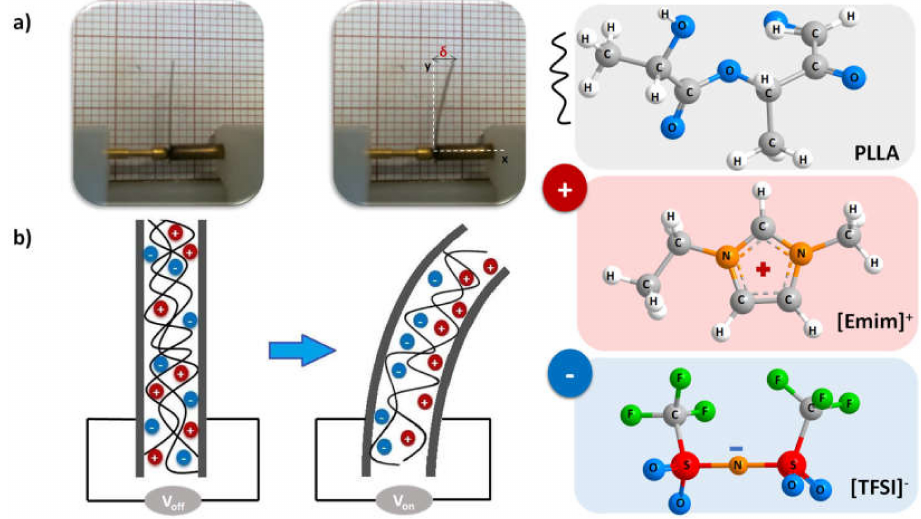
Figure 10. ( a ) Displacement observed for the PLLA / [Emim][TFSI]-DT25 TT140, upon an applied voltage of 10 Vpp at a frequency of 100 mHz; ( b ) Schematic representation of the ionic movement caused by an applied voltage.